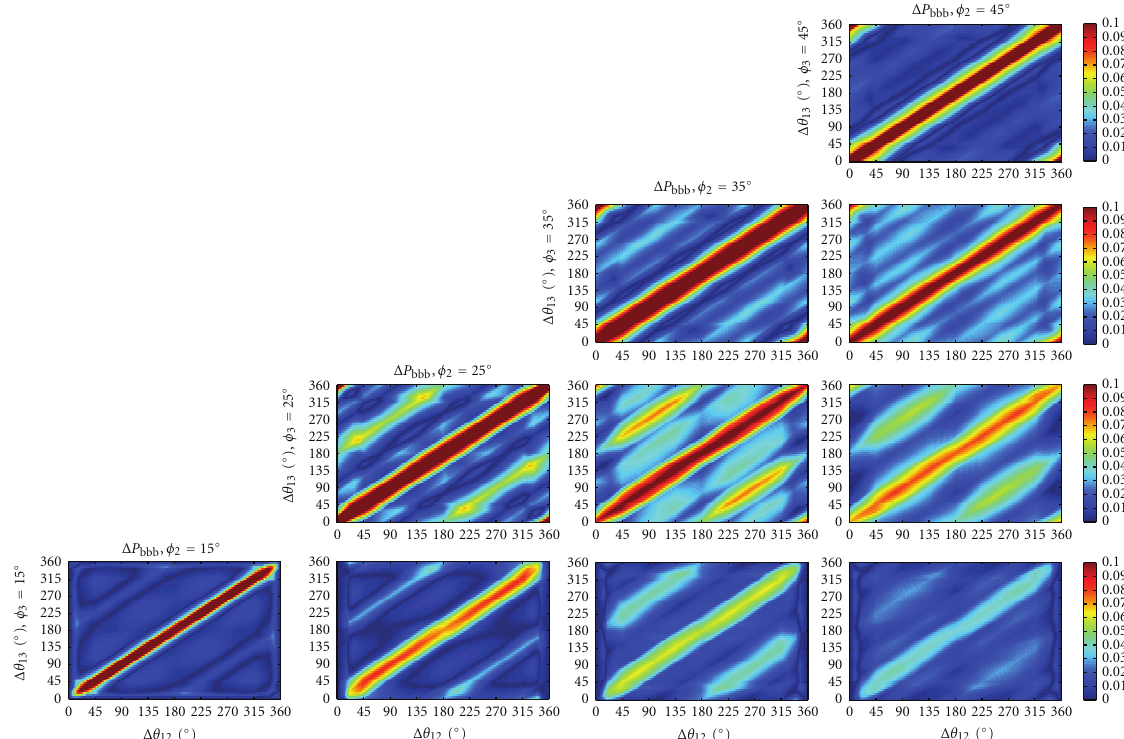
Figure 11: Di ff erence between measured and resimulated “bad bad bad” state probability ( Δ P bbb ) for di ff erent elevation angles ( φ 2 and φ 3 ) and azimuth angle separations ( θ 12 and θ 13 ) of two slave satellites. The master elevation is constant at φ 1 = 15 ◦ .